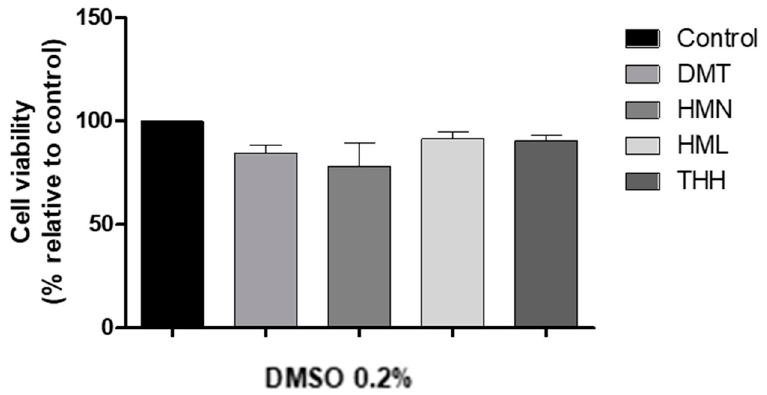
Figure 4. The effect of 0.2% of DMSO on N27 cell viability (24 h). The highest concentration used as a vehicle in the evaluation of the respective compounds was 0.2% of DMSO (Control—untreated cells (100 ± 0.00), DMT (1 µM; 84.86 ± 6.29), HMN (10 µM; 78.04 ± 20.13), HML (80 µM; 91.40 ± 5.89) and THH (10 µM; 90.49 ± 4.36); n = 3, values are shown as mean ± SEM; no significant difference was observed when performing ANOVA followed by Dunnett’s multiple comparison test).